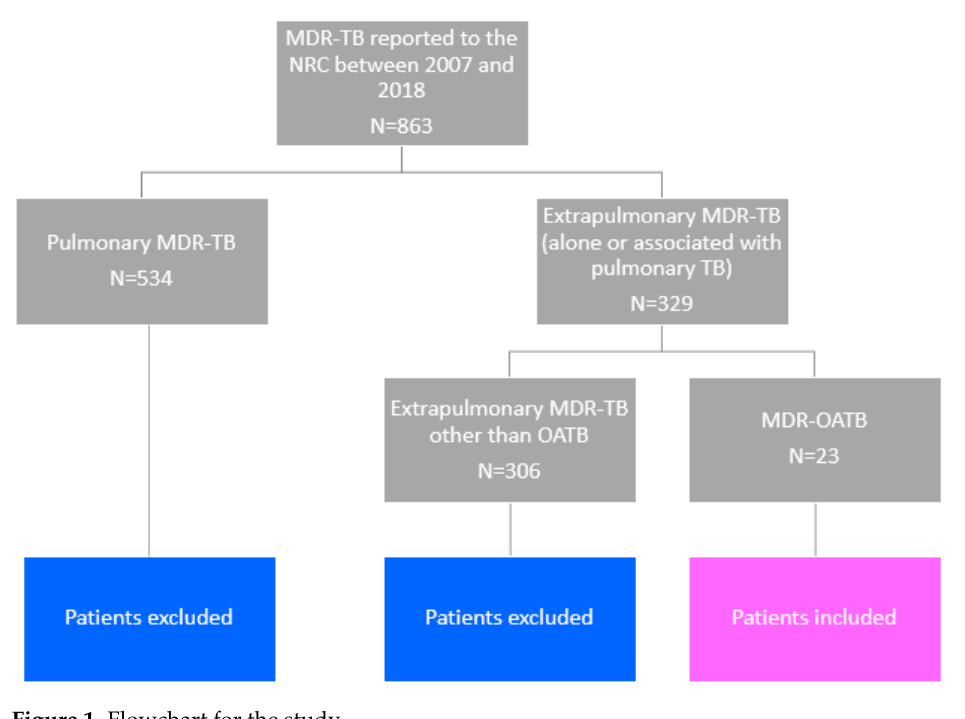
Figure 1. Flowchart for the study. Table 1. Characteristics of 23 patients with multidrug-resistant osteoarticular TB in France from 2007 to